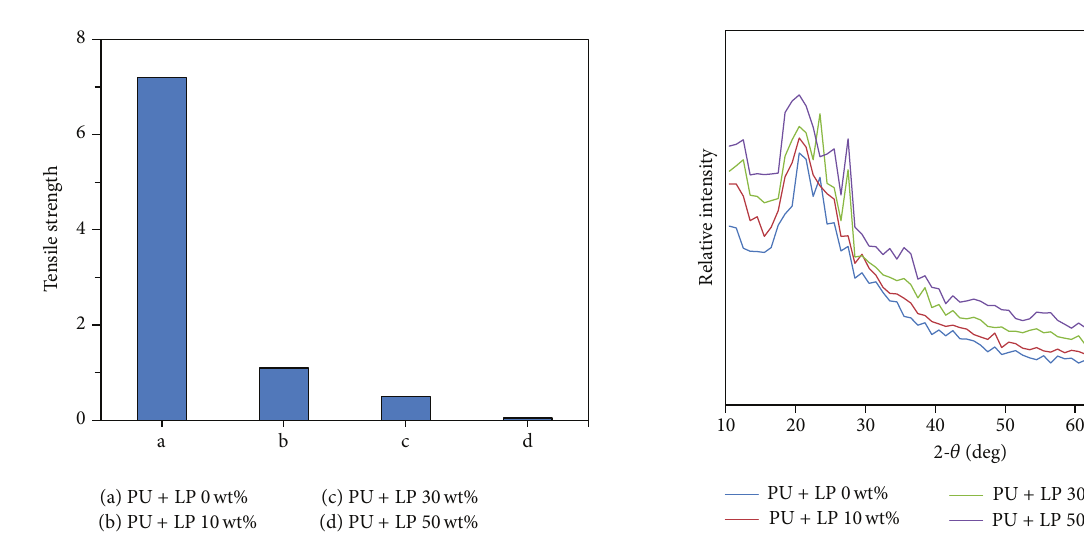
Figure 4: Tensile strength of electrospun PU mats with different amounts of LP.